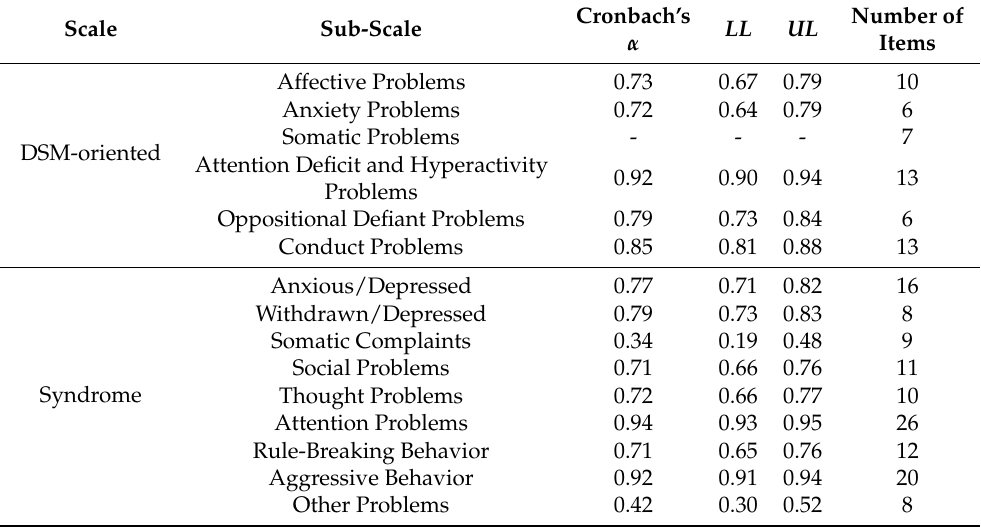
Table 3. Internal consistency for the